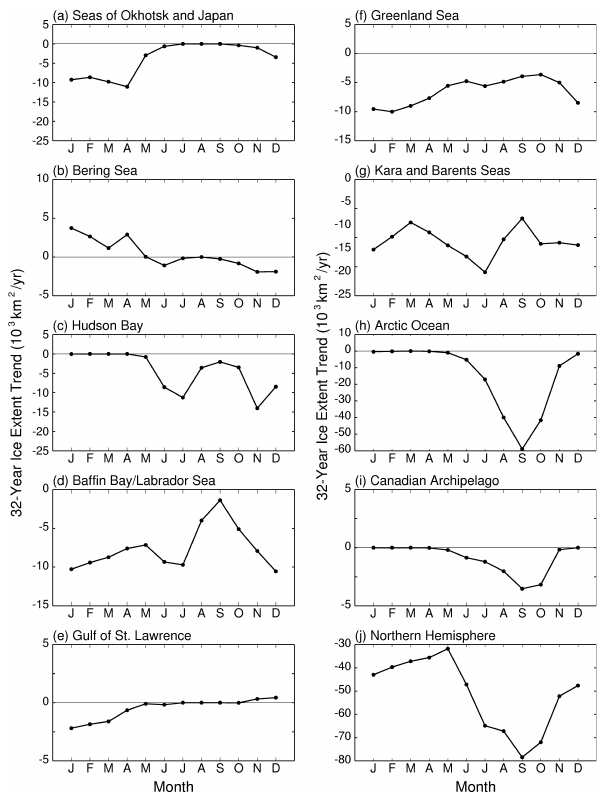
Fig. 4. Sea ice extent trends by month over the 32-yr period 1979– 2010 for (a) Seas of Okhotsk and Japan, (b) Bering Sea, (c) Hud- son Bay, (d) Baffin Bay/Labrador Sea, (e) Gulf of St. Lawrence, (f) Greenland Sea, (g) Kara and Barents Seas, (h) Arctic Ocean, (i) Canadian Archipelago, and (j) Northern